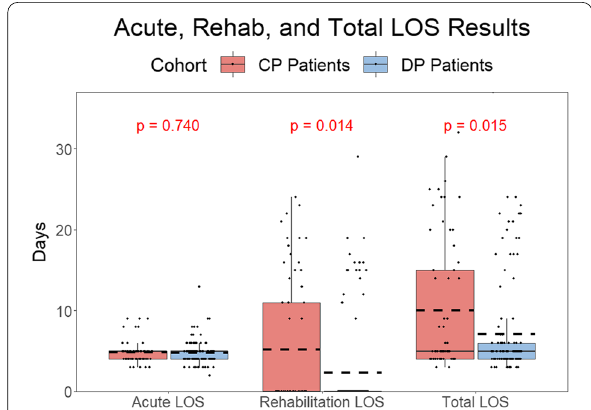
Fig. 2 Box and Whisker Plot of the Length of Stay results. Statistically significant differences were observed between the DP Patients and CP Patients for rehabilitation and total LOS